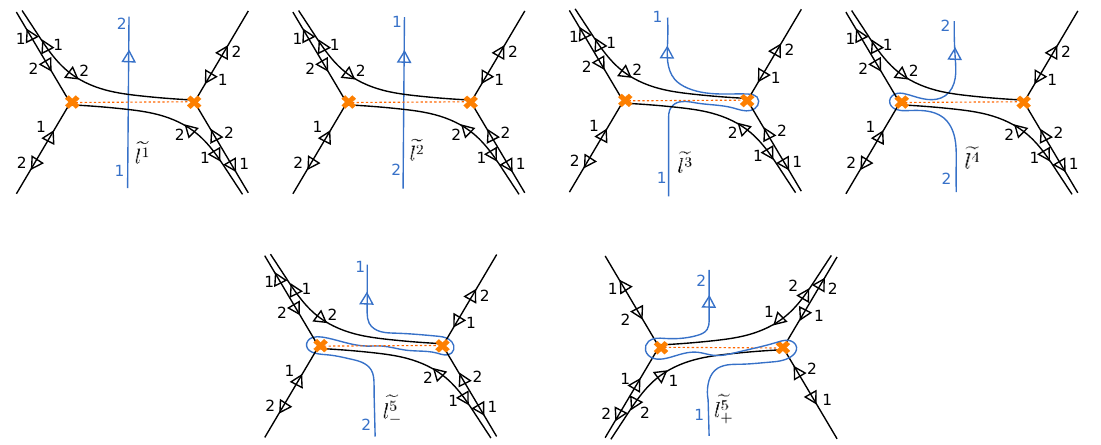
Figure 73 . Top: four lifts ~ l 1 ; : : : ; ~ l 4 of the open strand l which are present both before and after the (cid:13)ip. Bottom left: a lift ~ l 5 which is present only before the (cid:13)ip. Bottom right: a lift ~ l 5 (cid:0) is present only after the